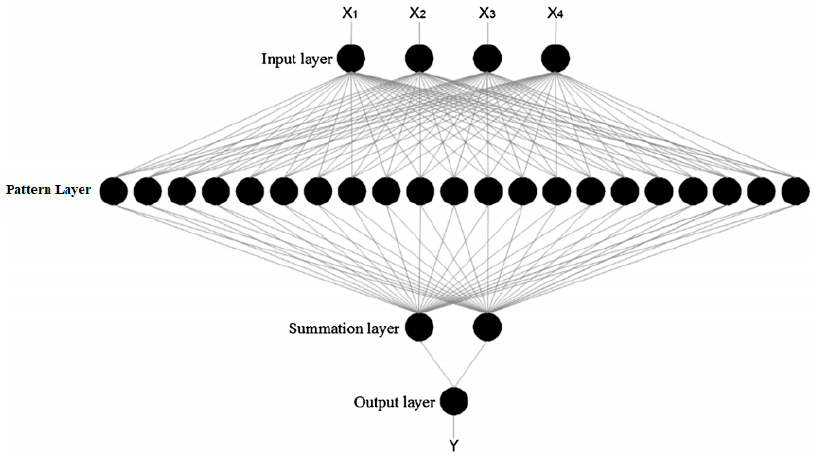
Figure 4. General structure of probabilistic neural network (PNN). Figure 3. General structure of probabilistic neural network